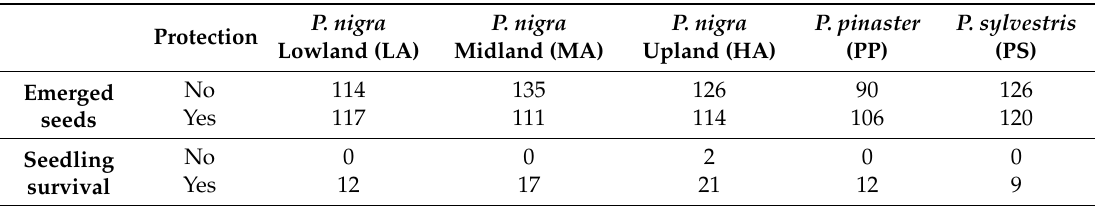
Table 1. Number of emerged seeds and survived seedlings for each experimental condition at the field site experiment. n = 144 seeds for each experimental